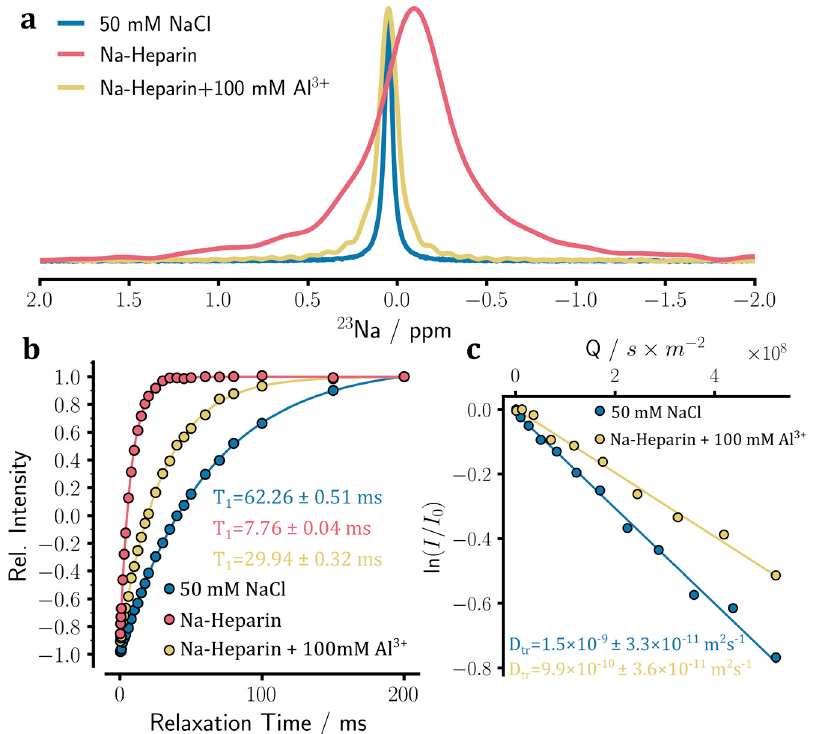
Figure 6. Aluminum ion binding to sodium heparin was monitored through 23 Na NMR experiments. ( a ) 1D 23 Na NMR spectra of sodium heparin, before and after the addition of 100 mM Al 2 (SO4) 3 . The spectrum of the reference NaCl solution is also shown. The addition of Al 3+ ion leads to 23 Na signal narrowing and peak displacement towards the chemical shift of free sodium ions. ( b ) Longitudinal spin-lattice ( T 1 ) relaxation of 23 Na signals measured through standard inversion- recovery experiments. The T 1 relaxation data indicate the partial release of sodium ions from heparin caused by the addition of Al 3+ ions. ( c ) Translational diffusion coefficient ( D tr ) of sodium ions measured through pulse field gradient NMR diffusion experiments. The D tr of sodium ions in the heparin with Al 2 (SO 4 ) 3 sample is larger than that of the heparin sample without added ions (see Figure 5c) but smaller than that of the reference NaCl sample. This is consistent with the partial release of sodium ions from heparin caused by added Al 3+ ions.